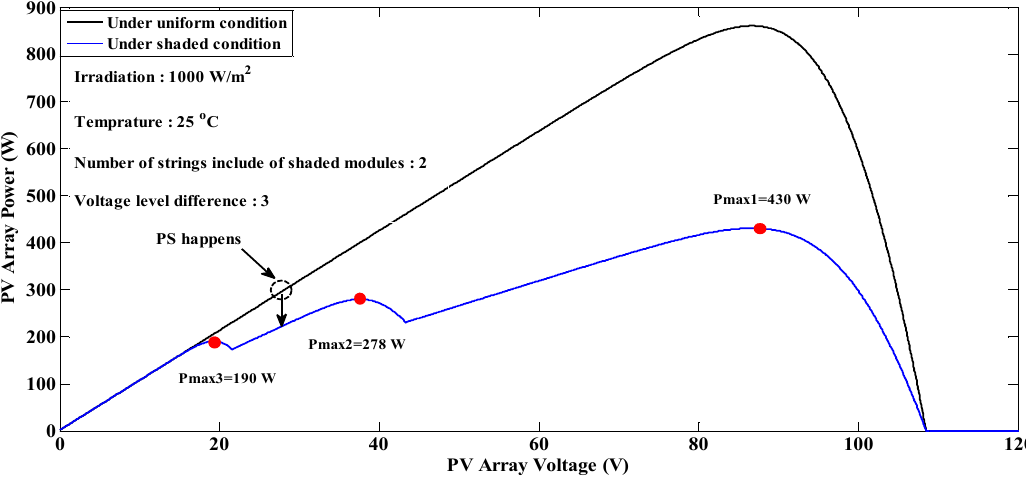
Figure 15. P-V curves under Figure 15. P ‐ V curves under PSC. Figure 15. P ‐ V curves under PSC.